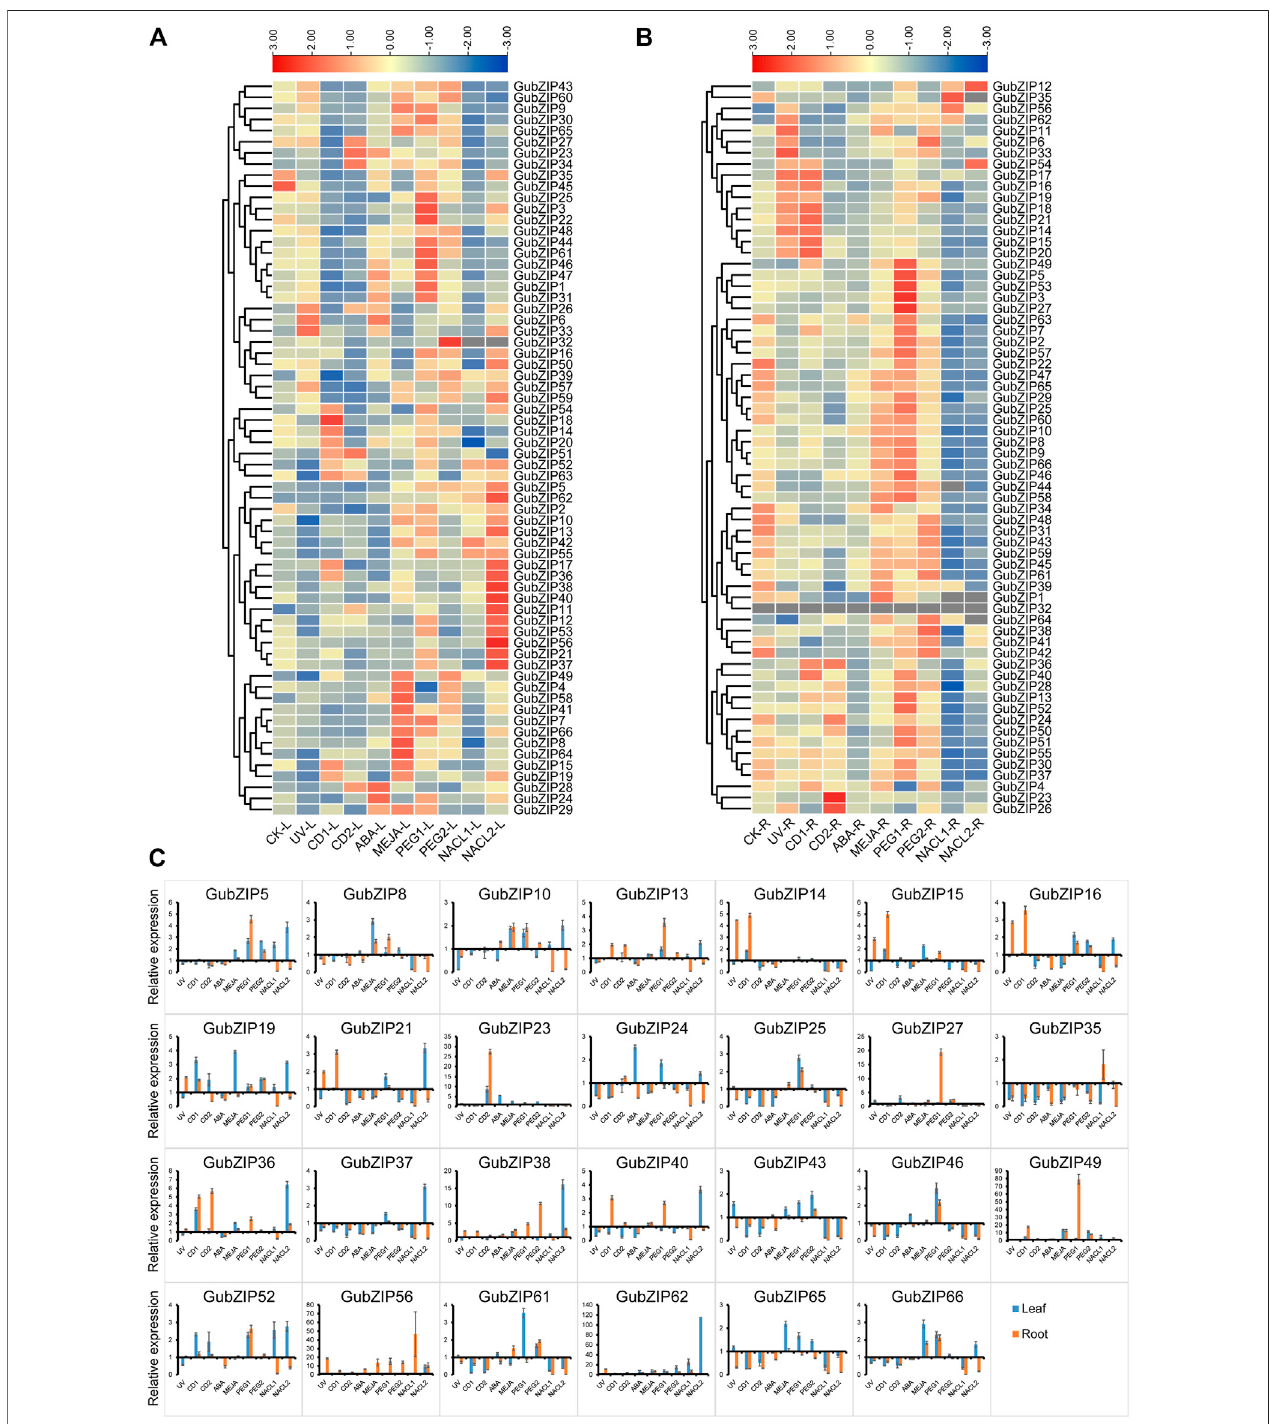
FIGURE7| Expressionpatternof bZIP genesin Glycyrrhizauralensis underabioticstress. (A) Heatmapsoftherelativeexpressionof bZIP genesinleaftissueof G. uralensis underabioticstress. (B) Heatmapsoftherelativeexpressionof bZIP genesinroottissueof G.uralensis underabioticstress.Thelevelofexpressionisindicated by the graded color code. (C) The qRT-PCR expression pro fi le of GubZIP genes under abiotic stress. The expression level of GubZIPs in the control group was standardized as “ 1. ” The vertical bar representsthe standard error ofthe average. Signi fi cance isindicated onthe bar graph by a – ifor the difference between gene expression; signi fi cance was con fi rmed by least signi fi cant difference (LSD) test ( p < 0.05).